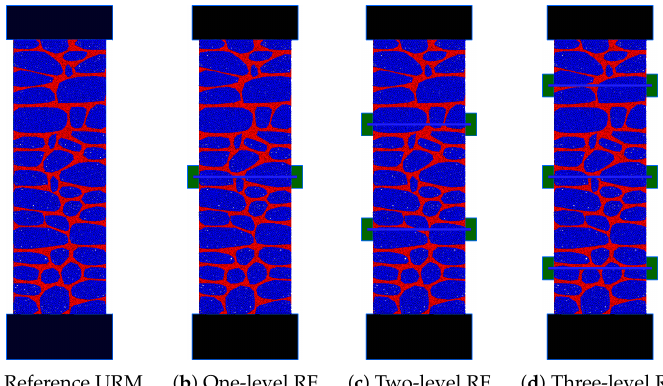
Figure 5. The 2D-PM and 2D-PMR models of the lateral faces of the rubble masonry walls with and without connectors; ( a ) without reinforcement; ( b ) one-level, ( c ) two-level, and ( d ) three-level, as in the experimental test.